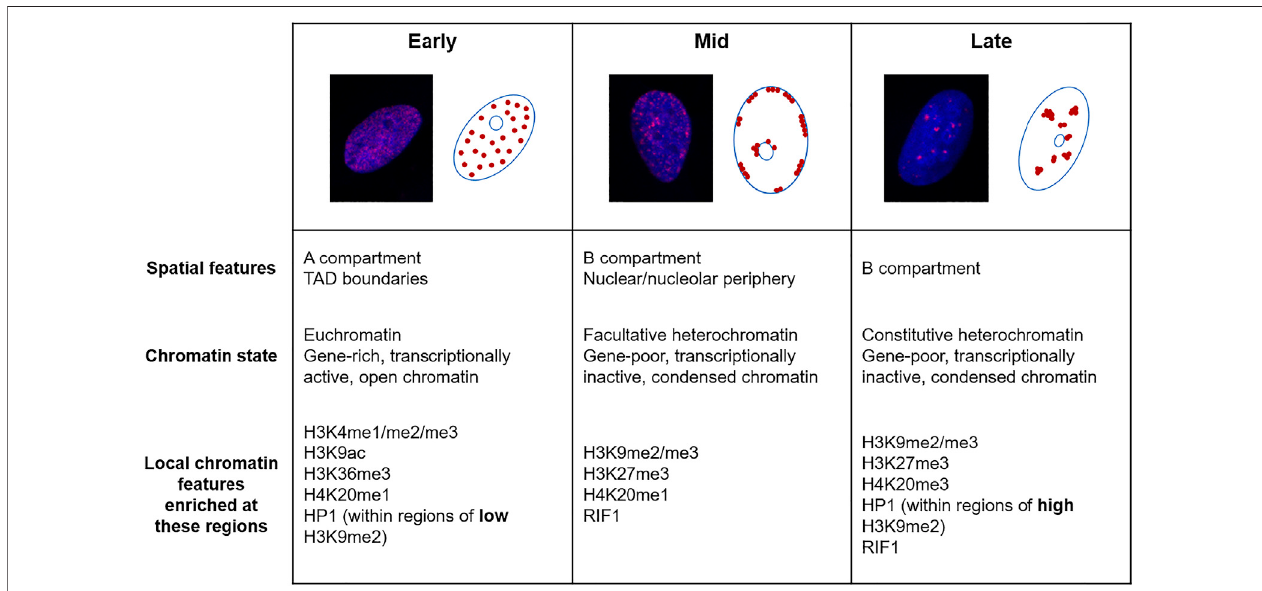
FIGURE1| Thereplicationtimingoftheeukaryoticgenome.FluorescencemicroscopyimagesofU2OScellslabelledwith5-ethynyl-2 ′ -deoxyuridine(EdU,red)and DAPI(blue)andschematicsshowingthethreedistinguishablesub-phasesofreplication;early,midandlate.Belowaredescriptionsofthechromatinreplicatedineachof these